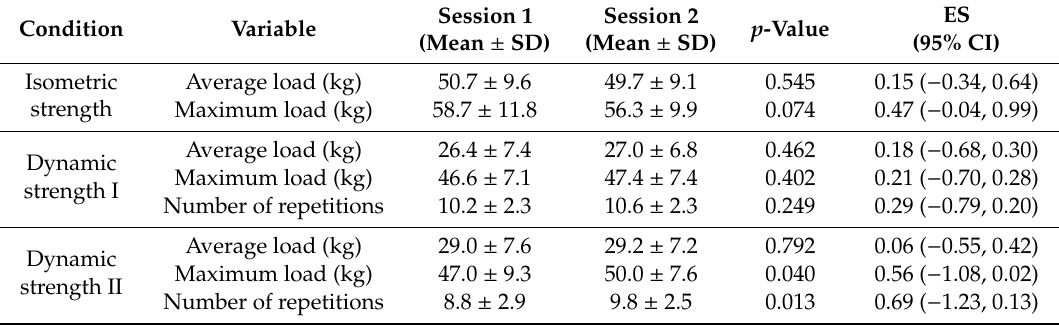
Table 1. Comparison of the average load, maximum load and number of repetitions during the isometric and dynamic (protocol I and II) strength conditions between both testing sessions.